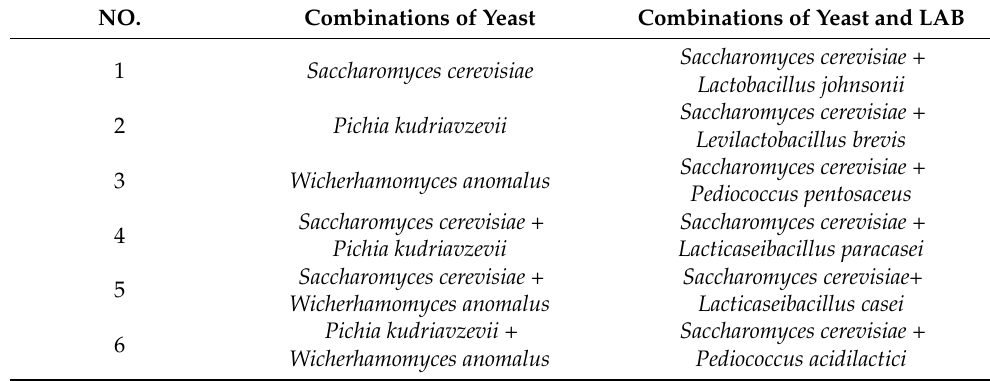
Table 7. Combinations of yeast and LAB.